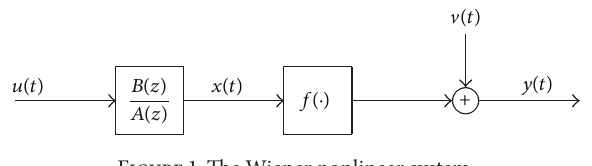
Figure 1: The Wiener nonlinear